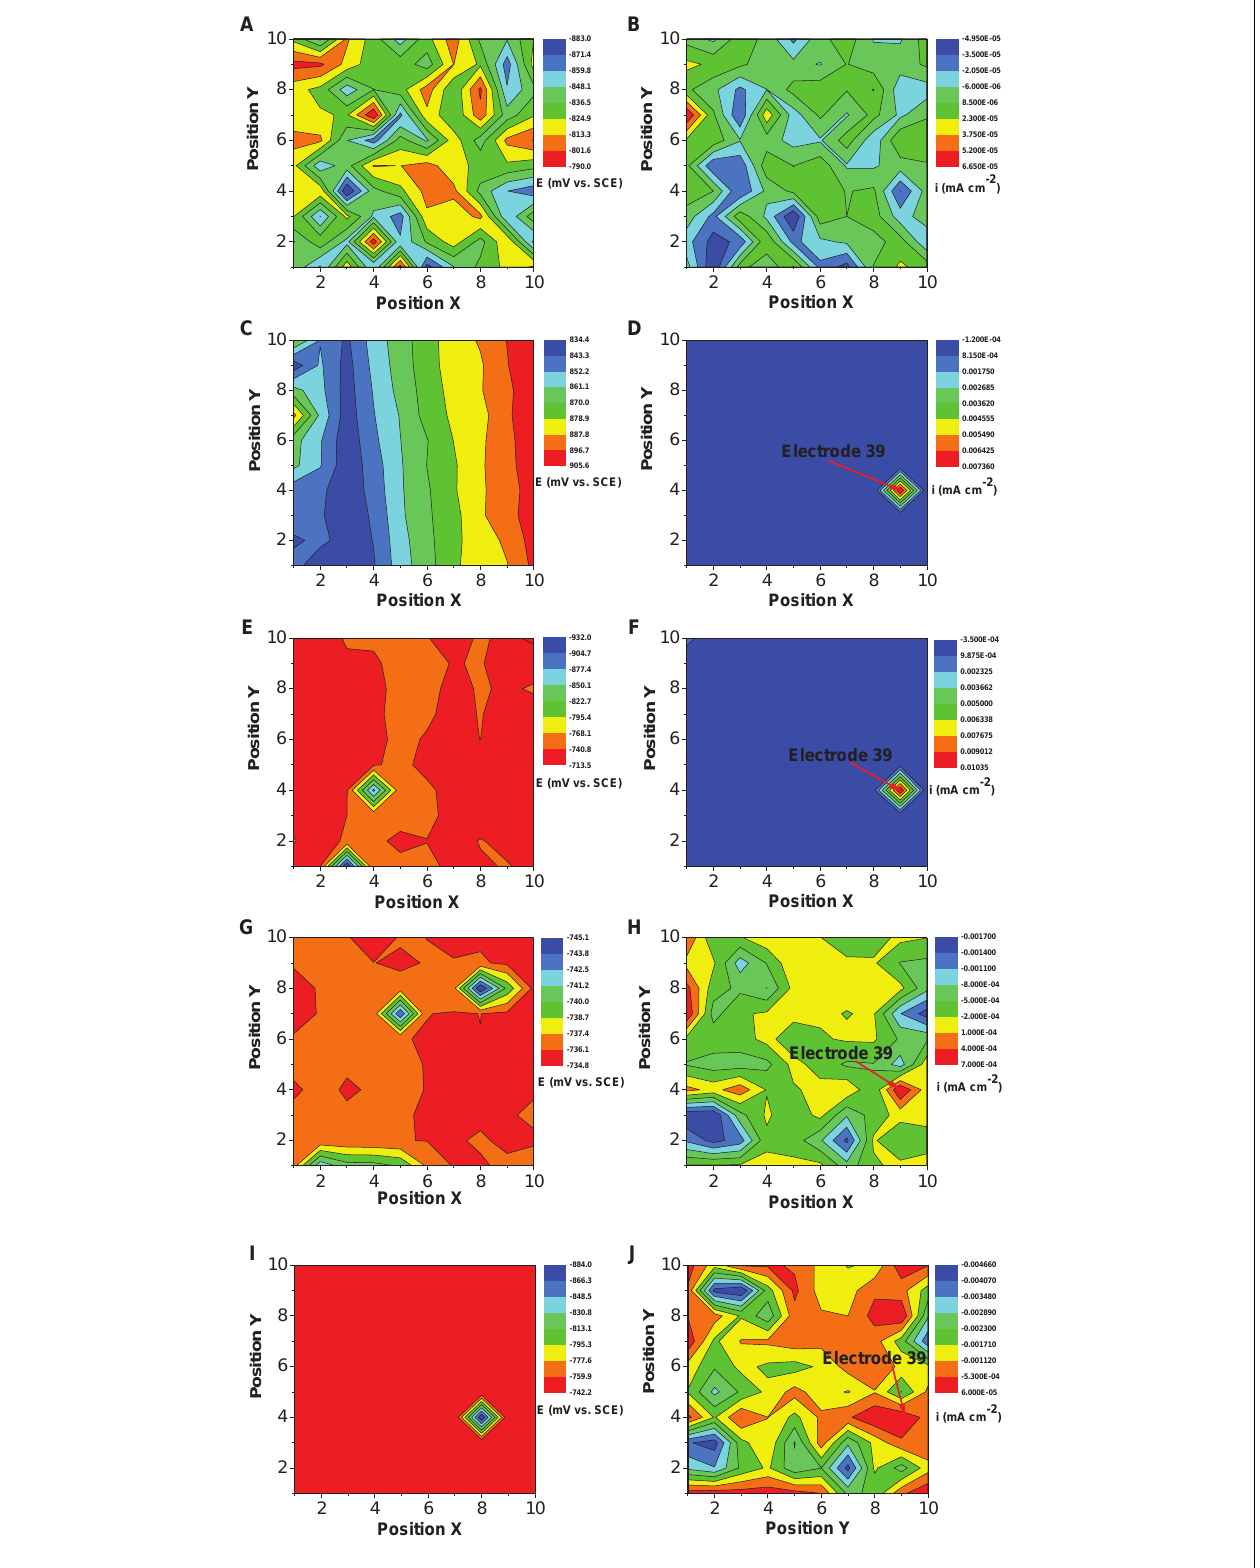
FIGURE 13 | Changes of corrosion potential (A,C,E,G,I) and galvanic current (B,D,F,H,J) distributions of Q235 WBE with incubation time in the presence of SRB in CO 2 -saturated simulations formation water: (A,B) 1 day, (C,D) 4 days, (E,F) 7 days, (G,H) 10 days, and (E,F) 14 days.